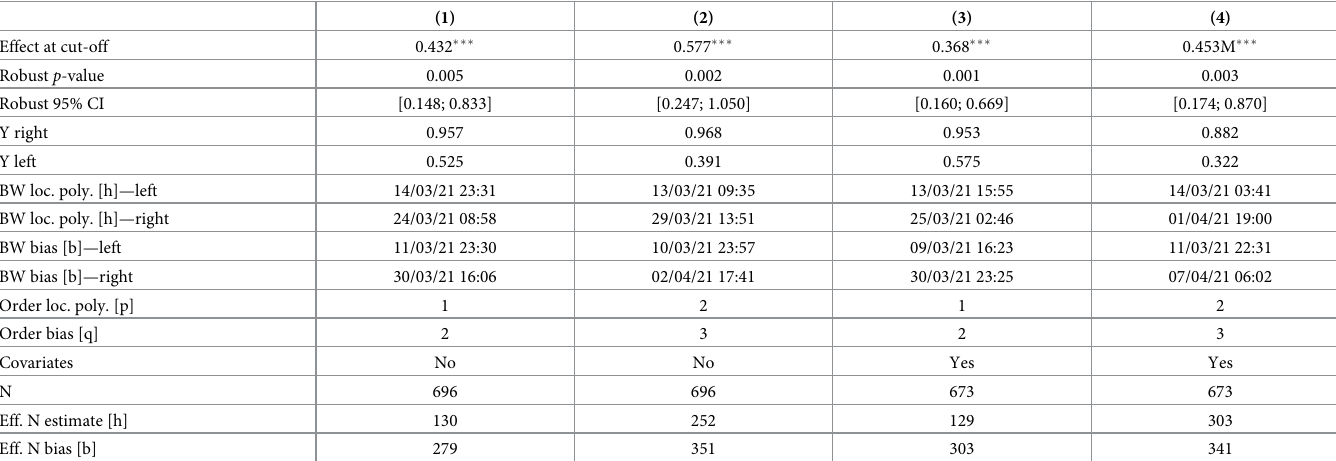
Table 6. RDD estimates with a different outcome definition: Y = 1 if ‘Yes, absolutely’, ‘Probably yes’, or ‘Probably no’, Y = 0 if ‘Definitely